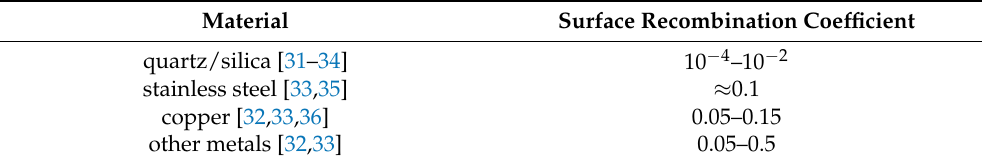
Table 1. Typical range of experimentally measured and theoretically determined values of the surface recombination coefficient (at T ≈ 300K) of hydrogen atoms on different materials as reported in